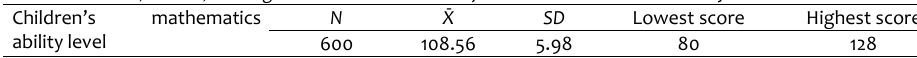
Table 6. Medium, lowest, and highest score distribution of children’s mathematics ability level Children’s